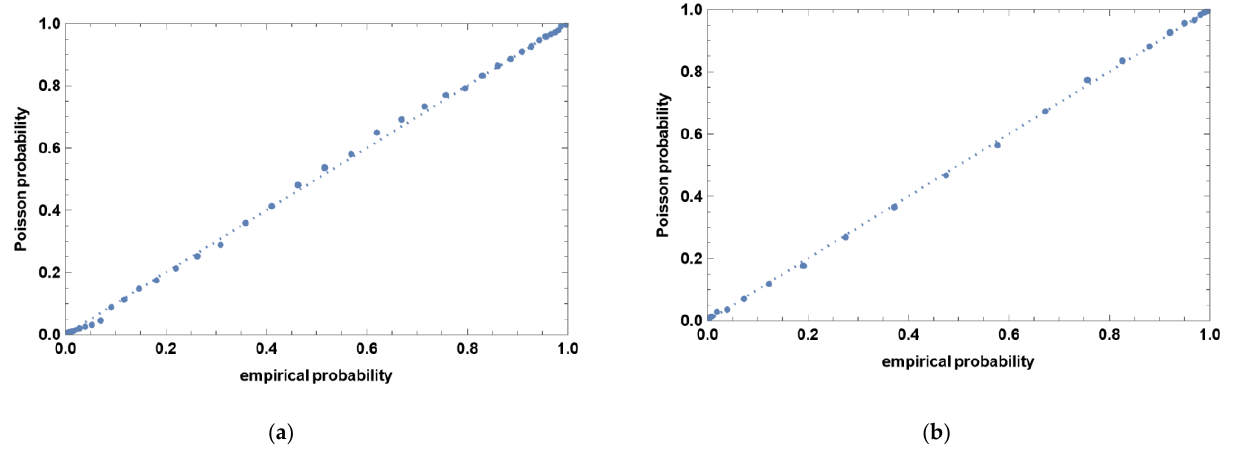
Figure 1. Probability plots comparing the simulated counts of refutations for BL -distributed logbooks with a Poisson distribution for ( a ) refutations using χ 2 ; ( b ) refutations using YCC ; plots using Mathematica